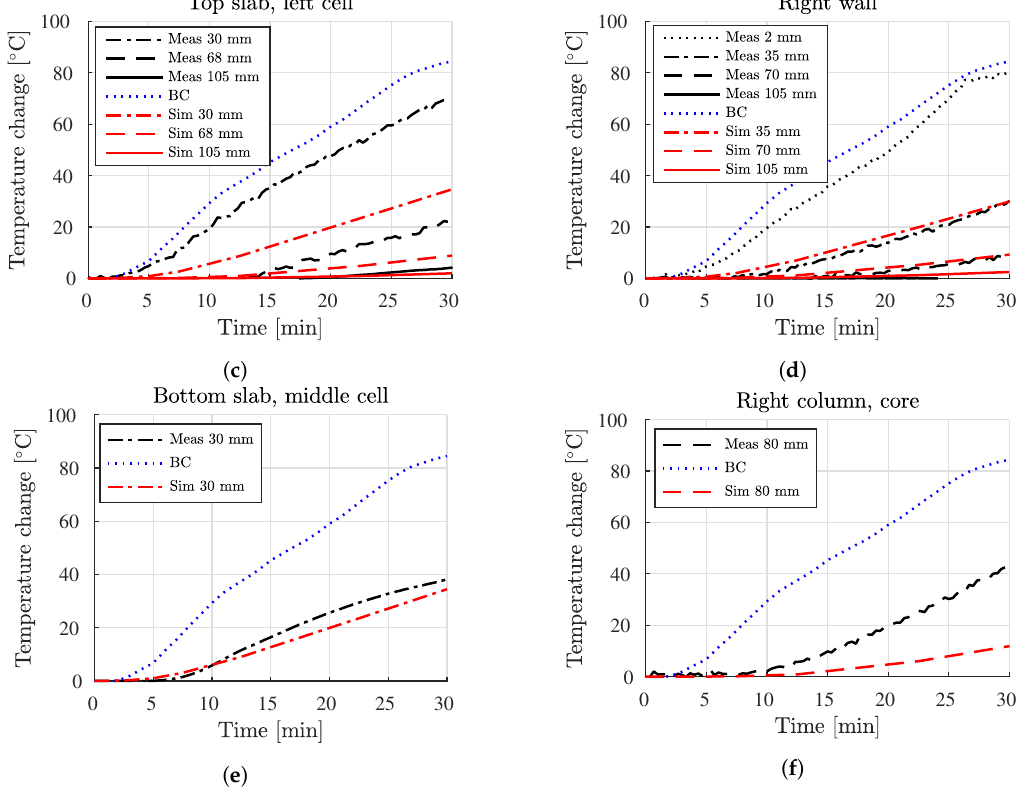
Figure 11. Comparison of simulated evolutions of the temperature inside the analyzed structure, obtained by prescribing a spatially-uniform temperature history along the entire inner surface, with experimental data: ( a ) top slab, at the midspan of the right cell, ( b ) top slab, at the midspan of the middle cell, ( c ) top slab, at the midspan of the left cell, ( d ) center of the right wall ( e ) bottom slab, at the midspan of the middle cell, and ( f ) core of the right column. Sim, simulated; Meas, measured.